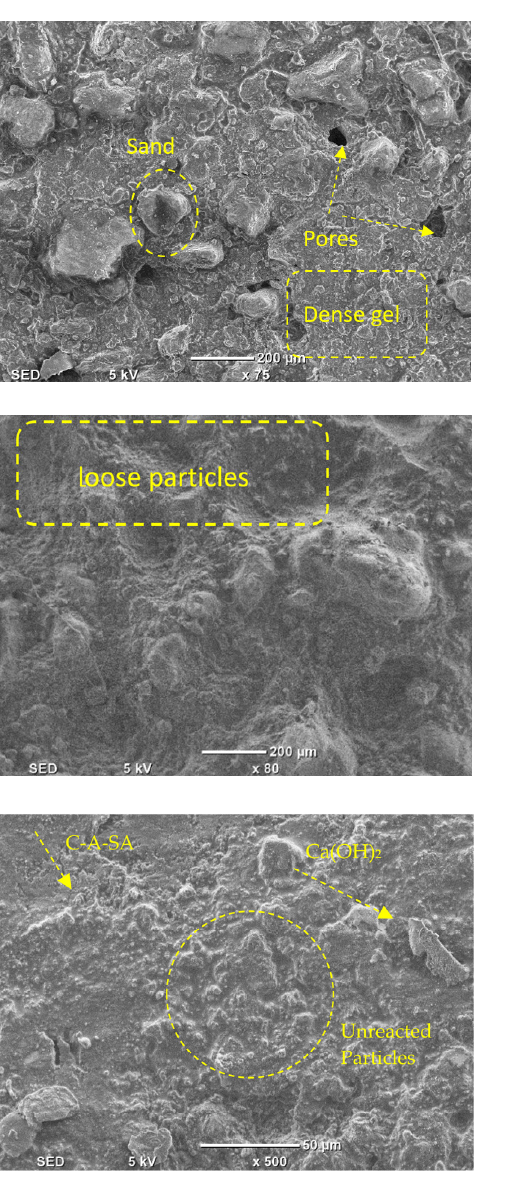
Figure 16. SEM analysis of alkali-activated slag-based samples with different levels of DCP. ( a ) 0% ; ( b ) 15% ; and ( c ) 60% .